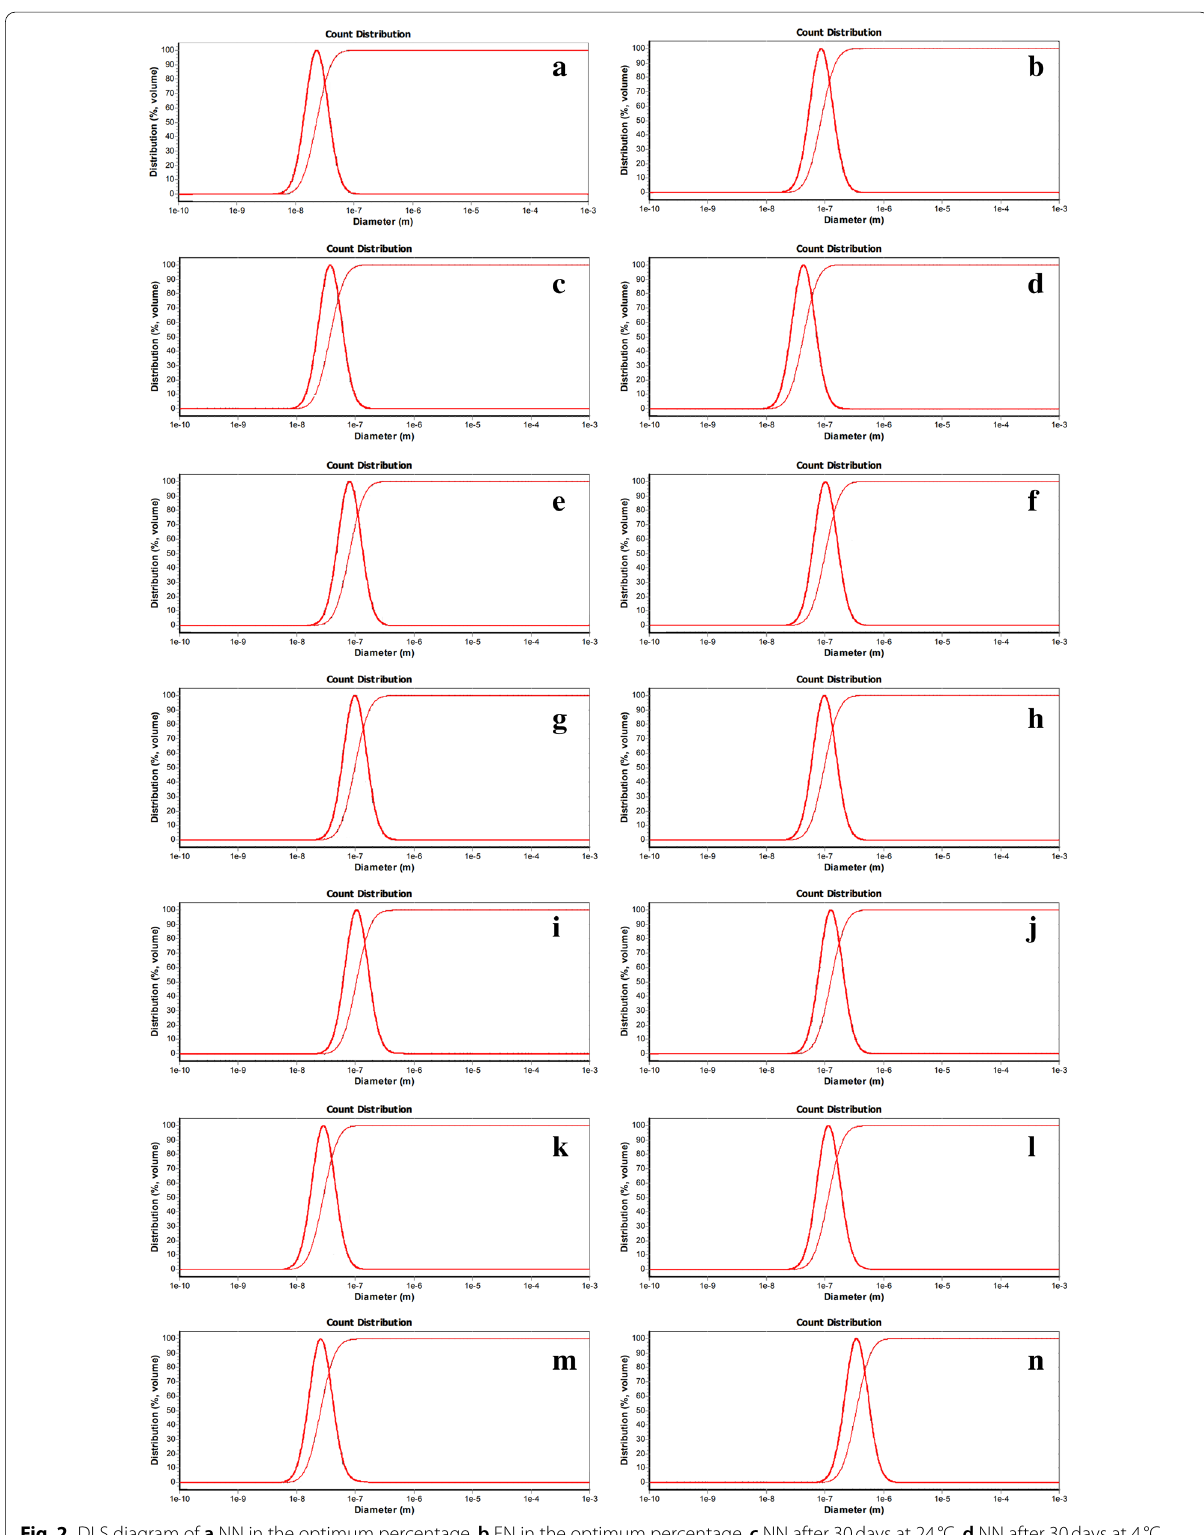
Fig. 2 DLS diagram of a NN in the optimum percentage, b FN in the optimum percentage, c NN after 30 days at 24 °C, d NN after 30 days at 4 °C, e NN after 30 days at 4 °C, f NN after 30 days at 20 °C, g FN after 30 days at 24 °C, h FN after 30 days at 4 °C, i FN after 30 days at − − 30 days at 20 °C, k NN after 90 days at 24 °C, l NE after 90 days at 24 °C, m NN after freeze-drying, and n FN after −